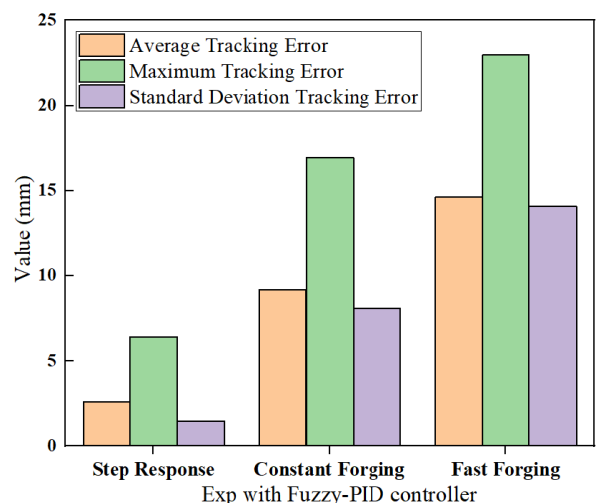
Figure 18. Tracking error of Fuzzy-PID-Based nonlinear control systems.